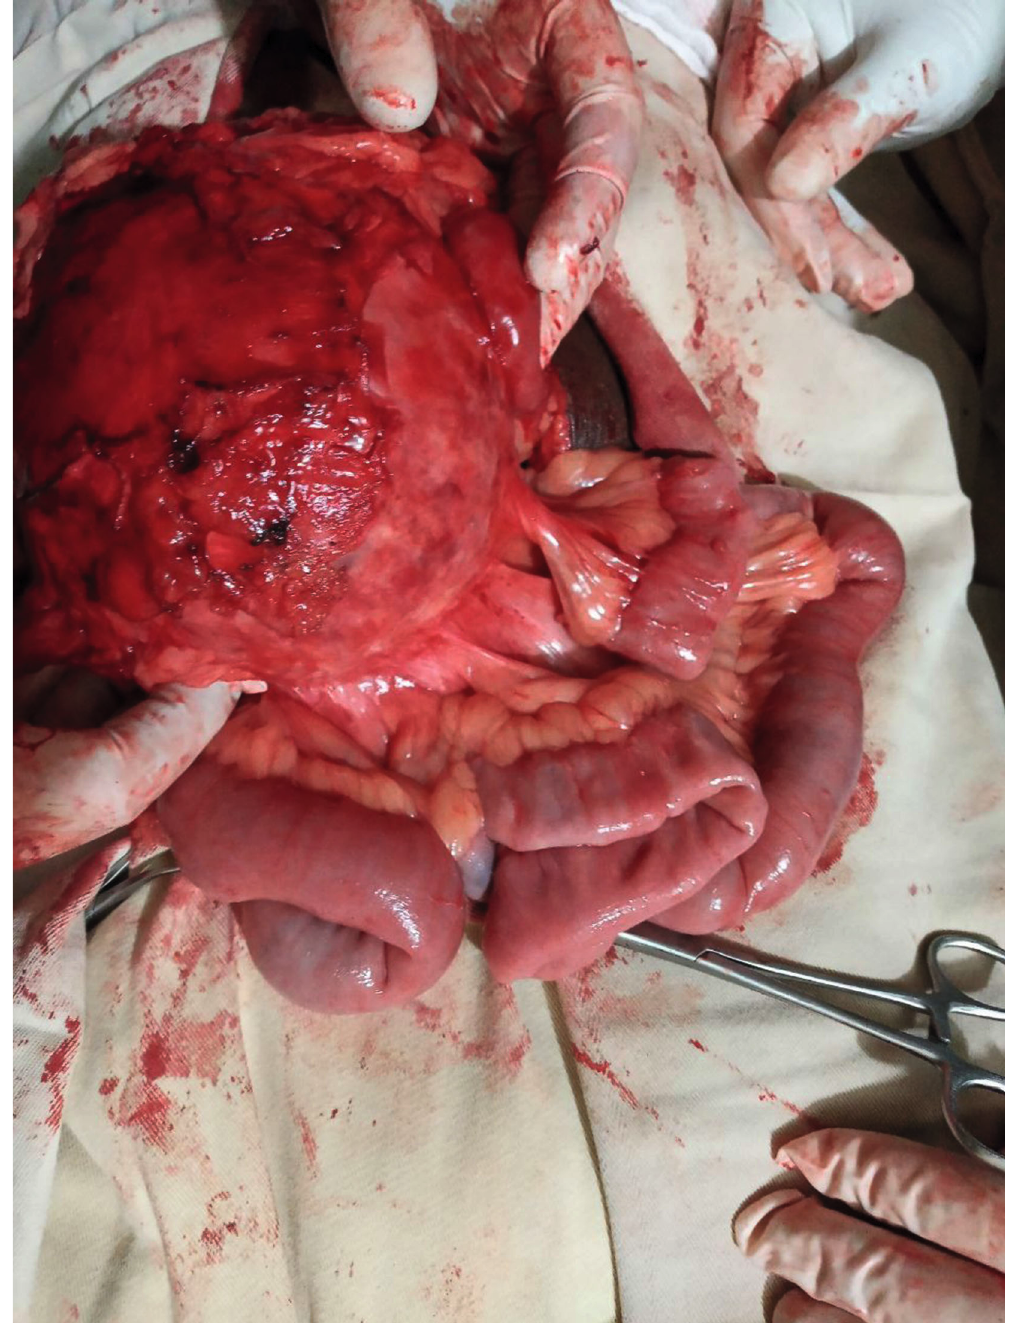
Figure 3: Cyst arising from the small bowel